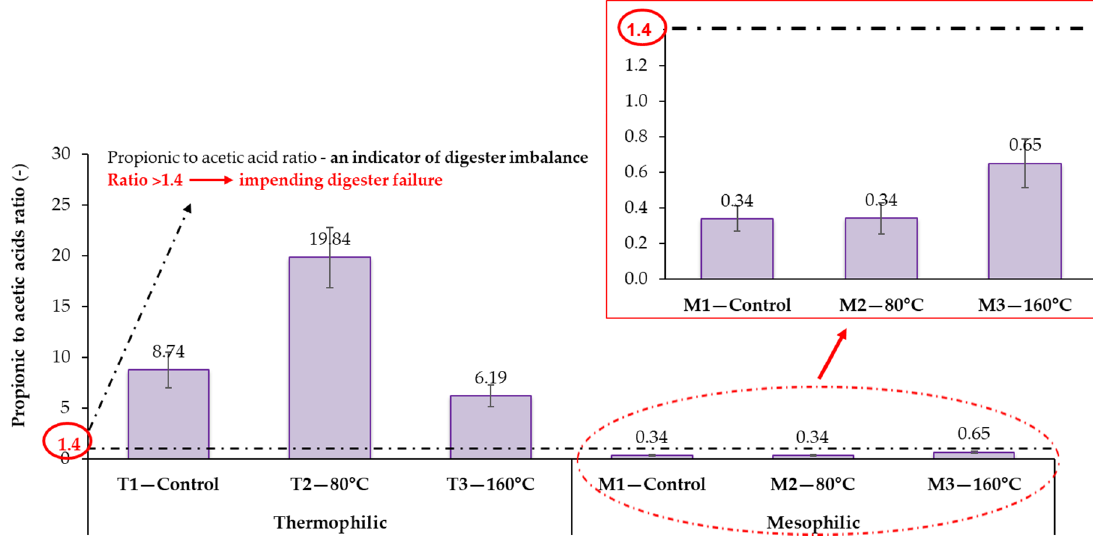
Figure 3. Ratios of propionic to acetic acids in the thermophilic and mesophilic